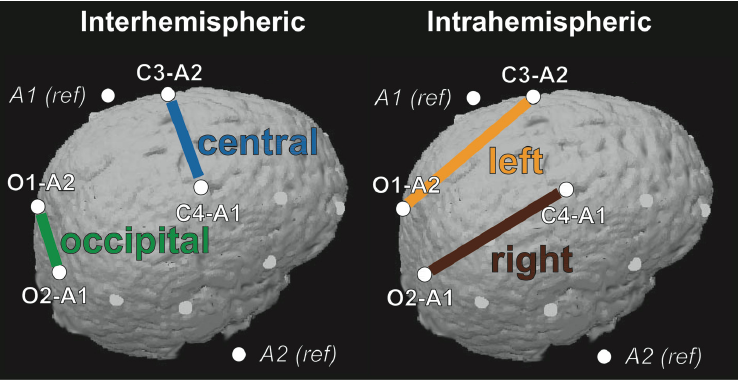
Figure 1. Coherence was derived from inter-hemispheric ( left panel ), central (C4A1-C3A2) and occipital (O2A1-O1A2) EEG derivations and from intra-hemispheric derivations ( right panel ) in the left (C3A2-O1A2) and right (C4A1-O2A1)